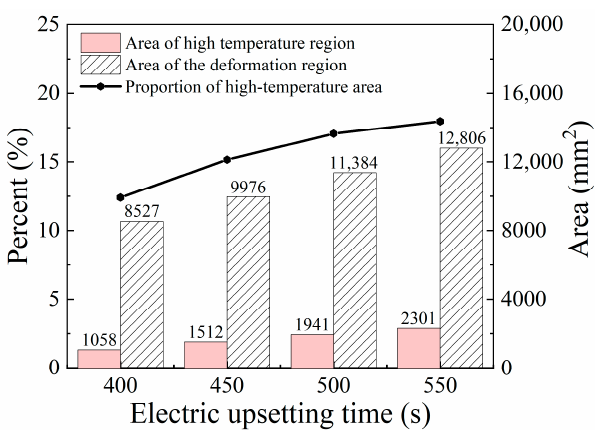
Figure 16. The area of high temperature region and the onion area at different electric upsetting moments during the intermediate stage.